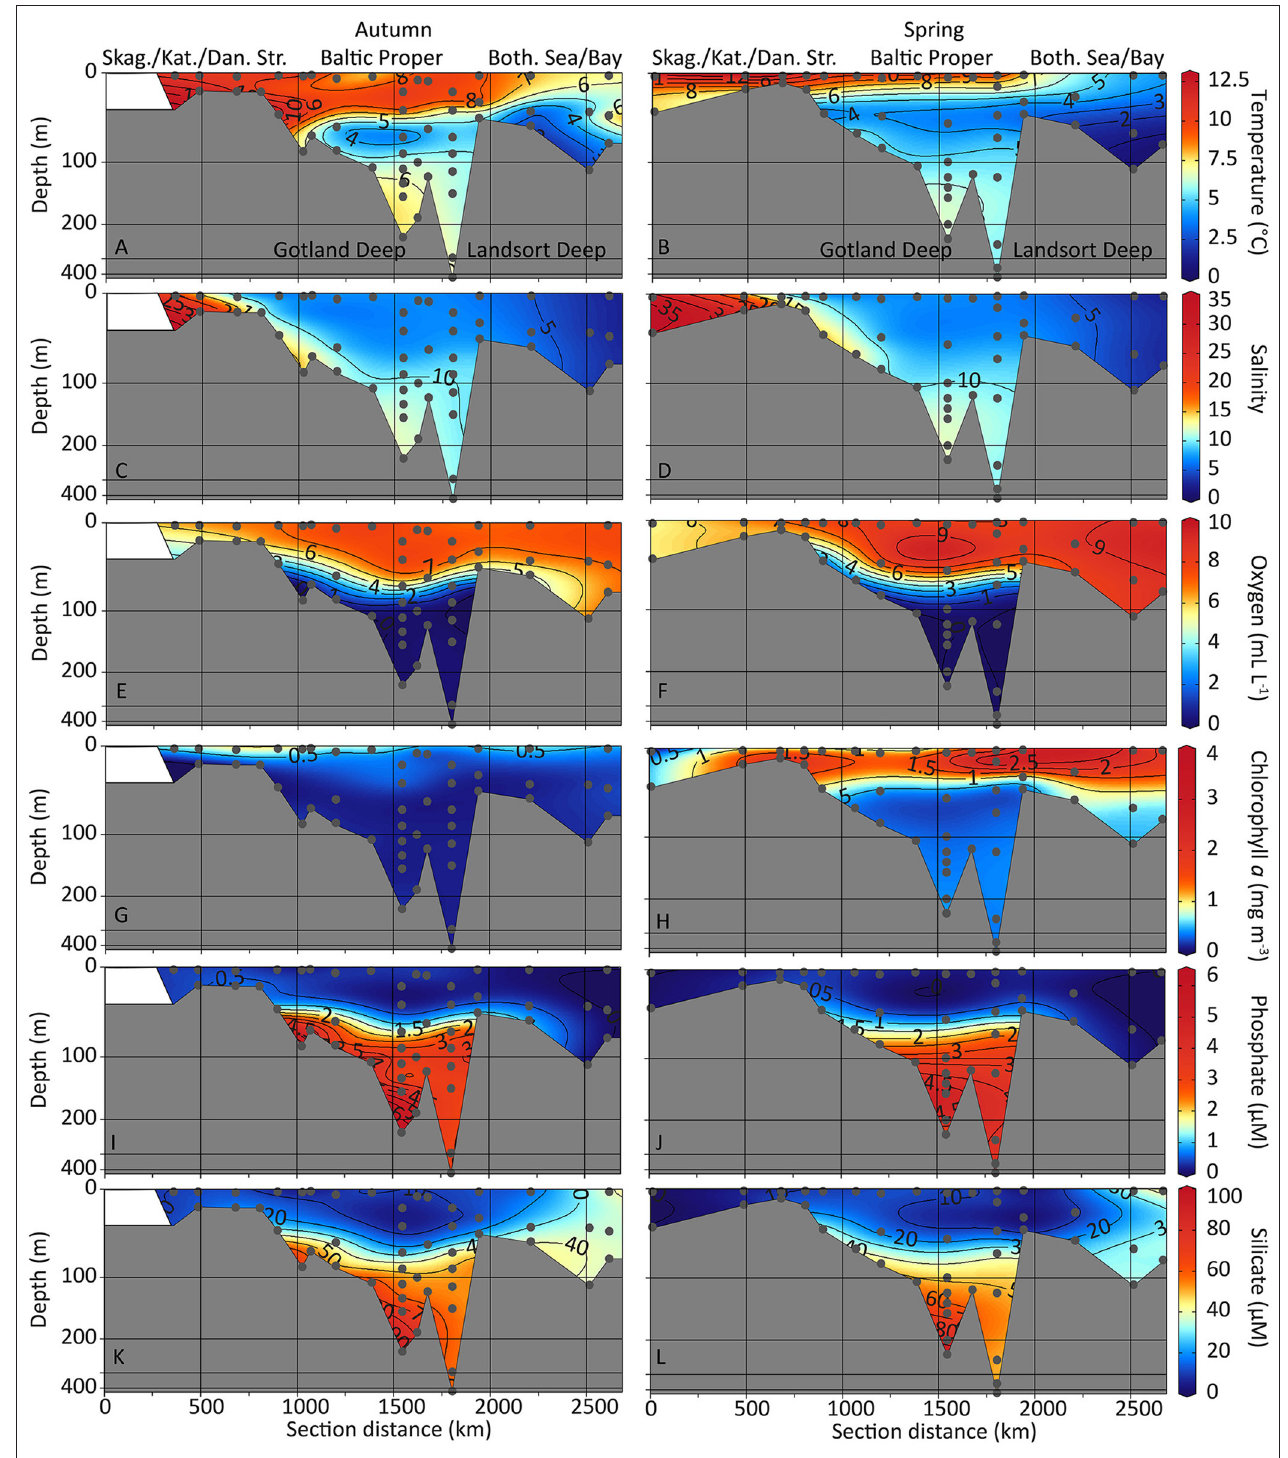
FIGURE 2 | Contour depth plots of the sampling transects. Water temperature (A,B) , salinity (C,D) , dissolved oxygen concentrations (E,F) , concentrations of chlorophyll a (G,H) , phosphate (I,J) , and silicate (K,L) are shown for autumn (left) and spring (right) sampling. Non-linear depth scale. Skag., Skagerrak; Kat., Kattegat; Dan. Str., Danish Straits; Both. Sea/Bay, Bothnian Sea and Bothnian Bay.